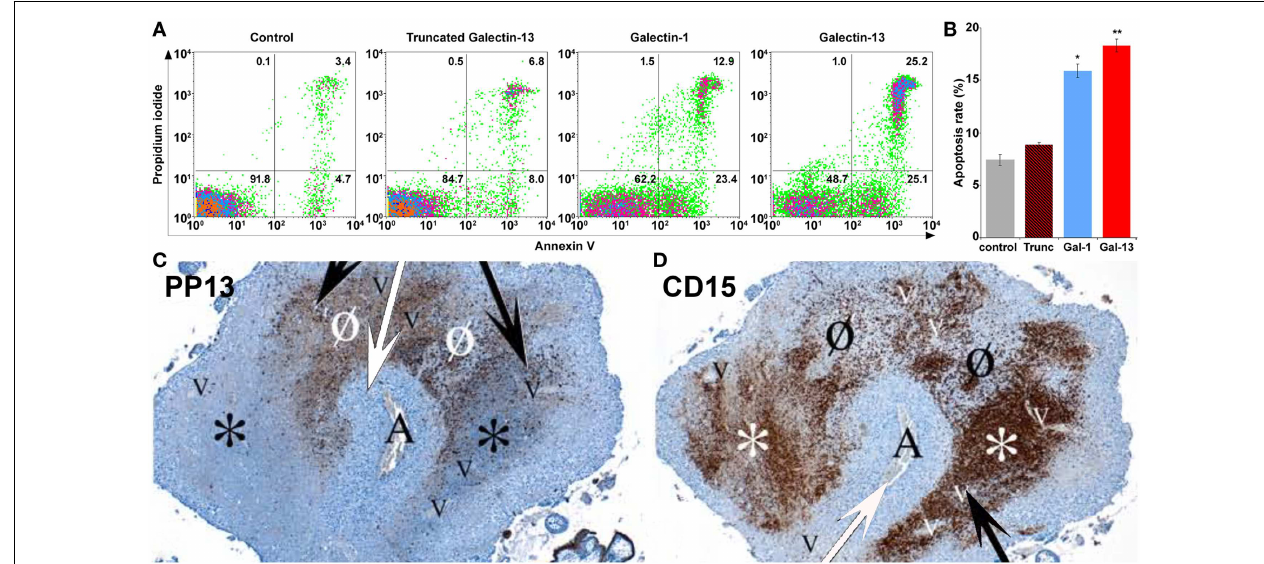
by decidual veins (“V” and black arrows). (C) PP13 immunostainings revealed areas of intense PP13 depositions consistent with early and active zones of necrosis (“ZONE”) formation (Ø), and areas with weak PP13 immunoreactivity consistent with end-stage “ZONEs” (*). (D) CD15 immunostainings revealed neutrophil accumulation showing an inverse pattern with PP13 depositions.The least intense staining was observed in early “ZONEs” (Ø), while the most intense staining in end-stage “ZONEs” (*). Figures and data (A,B) were published in Ref. (23). Figures (C,D) were published in Ref. (8). Kind permission for the reuse and modification of figures was obtained from the National Academy of Sciences of the United States of America (A,B) and SAGE US (C,D)